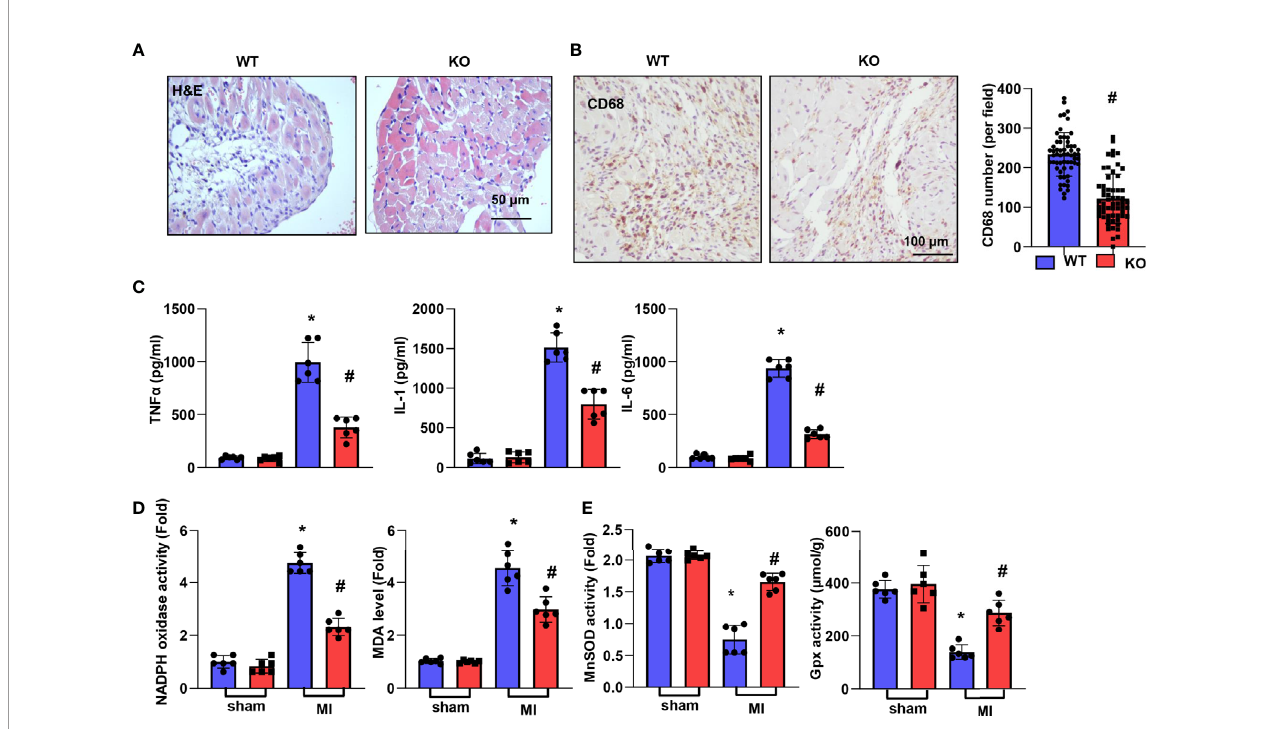
FIGURE 3 | CTRP1 de fi ciency suppresses cardiac in fl ammation and OS post MI. (A) H&E staining. (B) CD68 staining and quanti fi cation of the results in CTRP1 knockout mice at 28 days post MI (n=6 per group). (C) In fl ammatory cytokine levels in heart tissue post MI (n=6 per group). (D , E) Oxidase and anti-oxidase activities and MDA levels in heart tissue post MI (n=6 per group). * P <0.05 vs. the WT-sham group. # P <0.05 vs. the WT-MI